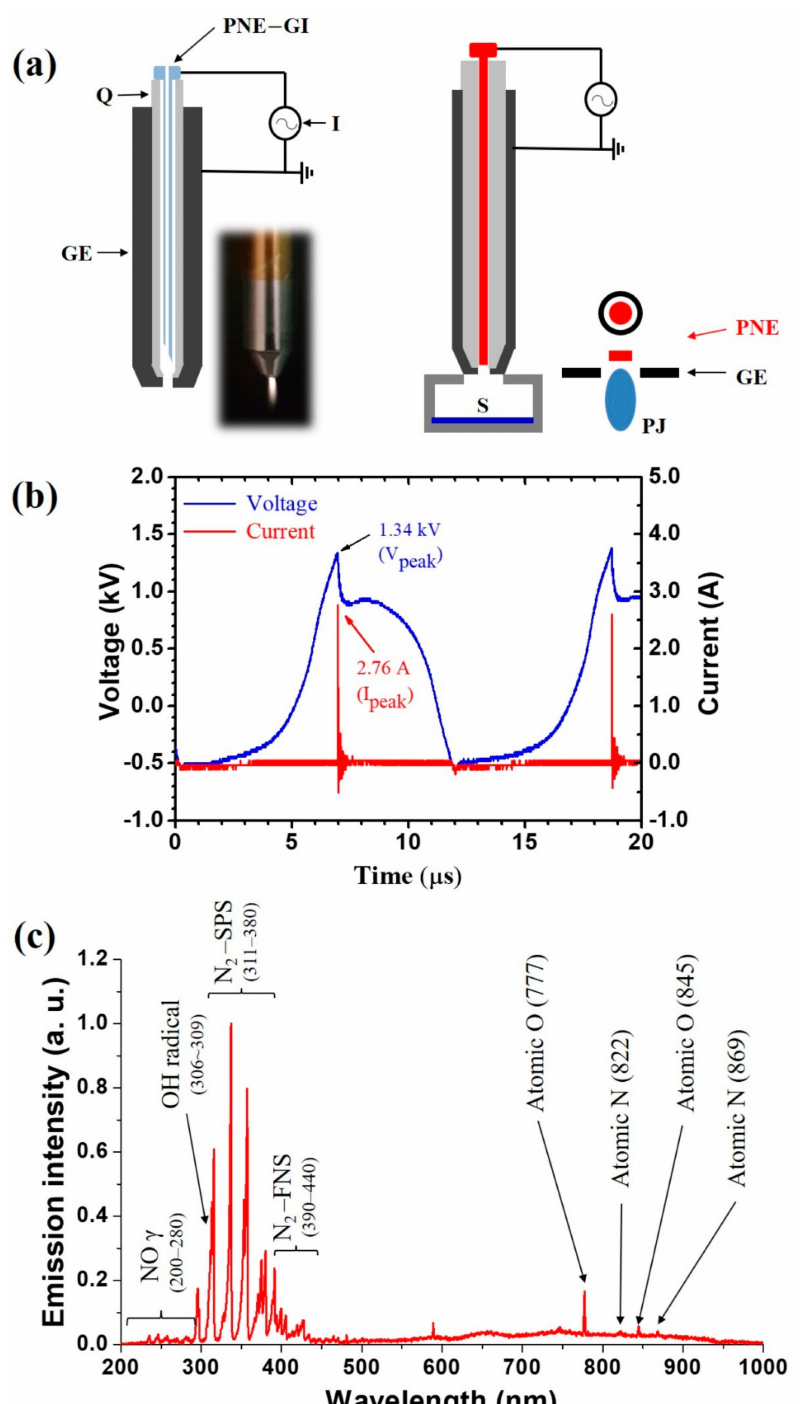
Figure 1. ( a ) Experimental layout, photo and schematic diagram of an electric shock-free, atmospheric-pressure air plasma jet, I, Inverter, PNE-GI, Powered needle electrode and Gas input, Q, Cylindrical quartz tube, GE, Grounded electrode, S, Sample, PJ, Plasma jet, ( b ) typical voltage and current profiles of the plasma discharge, and ( c ) optical emission spectrum of the soft plasma